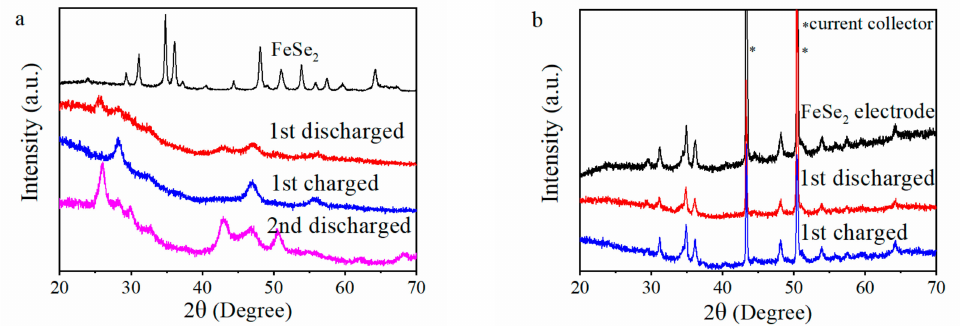
Figure 4. XRD patterns of the FeSe 2 electrode in ( a ) FeSe 2 | Mg 2 + / Li + | Mg cell and ( b ) FeSe 2 | Mg 2 + | Mg cell at di ff erent discharging / charging